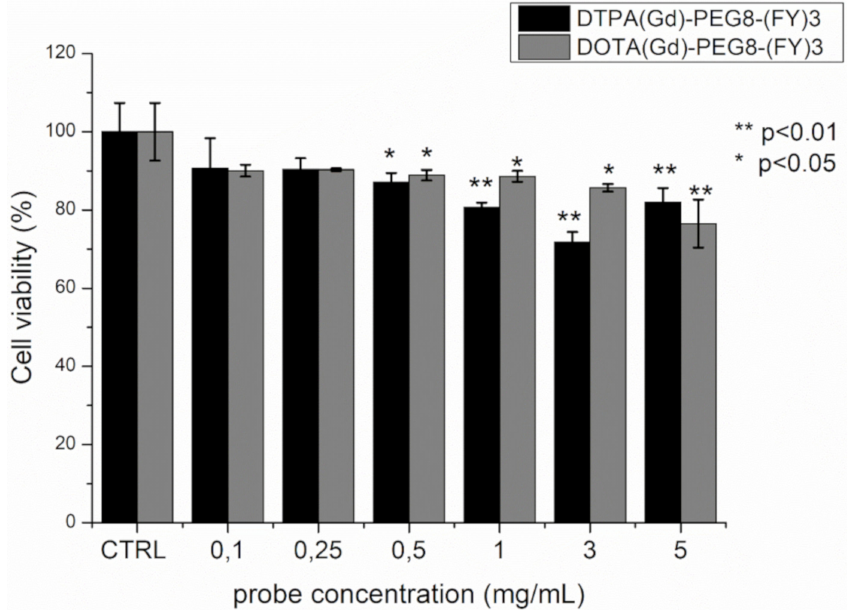
Figure 6. Cell viability percentage, evaluated by MTT assay, after 4 h incubation of TS / A mouse mammary adenocarcinoma with various concentrations of DOTA(Gd)-PEG8-(FY)3 and DTPA(Gd)-PEG8-(FY)3. Data are expressed as the mean ± SD ( n = 3). Statistically di ff erent values with respect to control cells are indicated with * for p < 0.05 and ** for p <